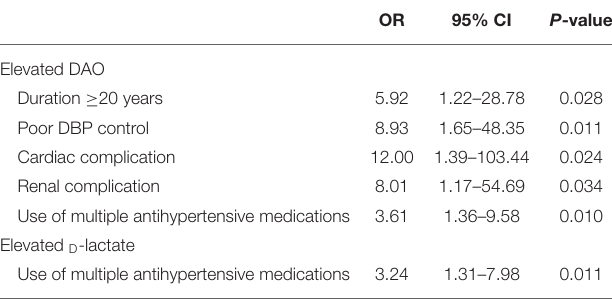
TABLE 4 | Logistic regression analyses of risk of impaired intestinal barrier due to hypertension-related factors.